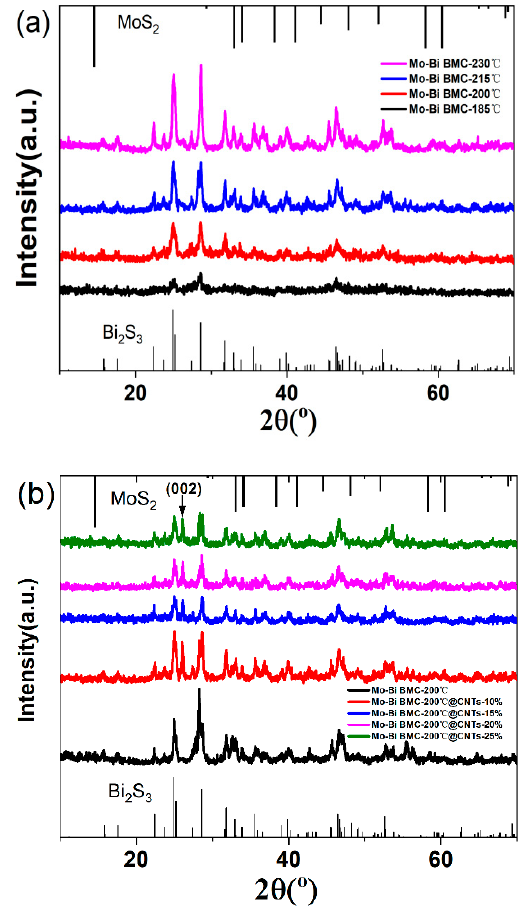
Figure 1. X-ray di ff raction (XRD) patterns of the ( a ) Mo–Bi BMC, and ( b ) Mo–Bi Figure 1. X-ray diffraction (XRD) patterns of the ( a ) Mo–Bi BMC, and ( b ) Mo–Bi BMC@CNTs.